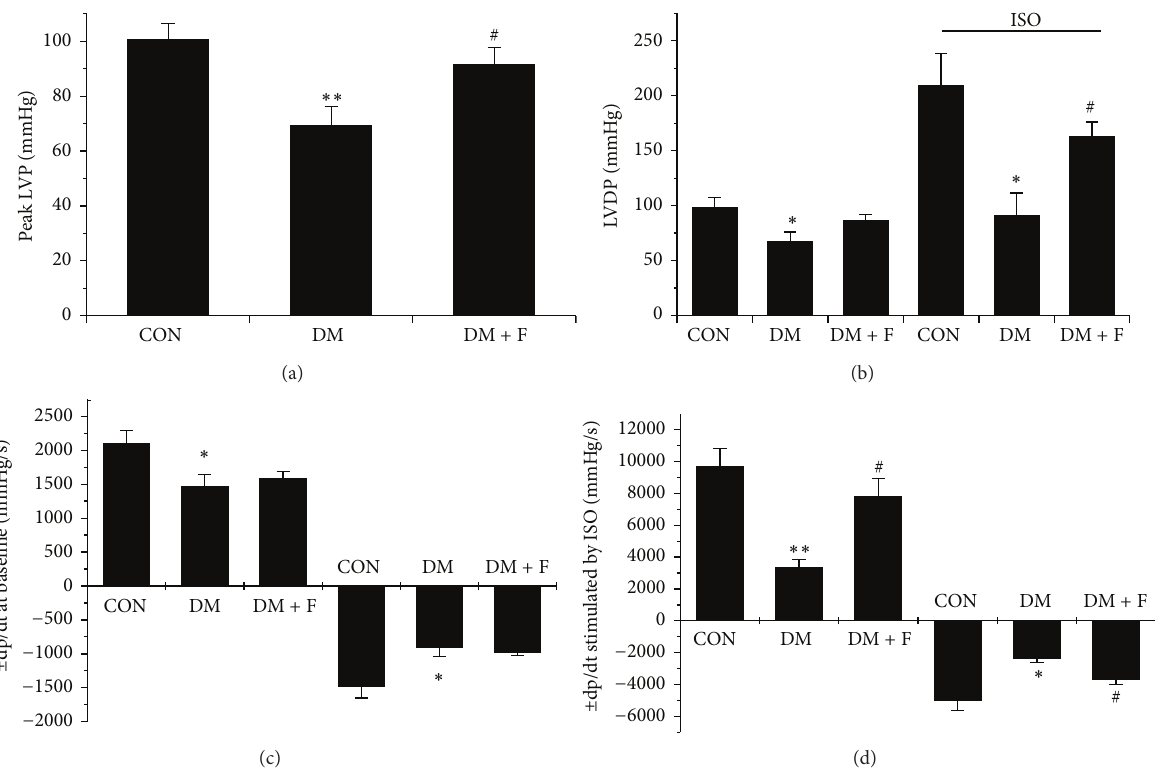
Figure 1: Influence of LMWF administration on myocardial contractility of diabetic GK rats determined in isolated perfused hearts. Peak left ventricular pressure (LVP) was shown in (a). Left ventricular developed pressures (LVDP) at both baseline levels and stimulated by isoprenaline (ISO, 10 −5 M) were shown in (b). The maximum rates of contraction and relaxation of myocardium ( ± dp/dt) at both baseline levels and in response to ISO stimulation were shown in ((c), (d)). 𝑁 = 5–7 for each group, ∗ 𝑃 < 0.05 , ∗∗ 𝑃 < 0.01 , versus control group; # 𝑃 < 0.05 versus DM